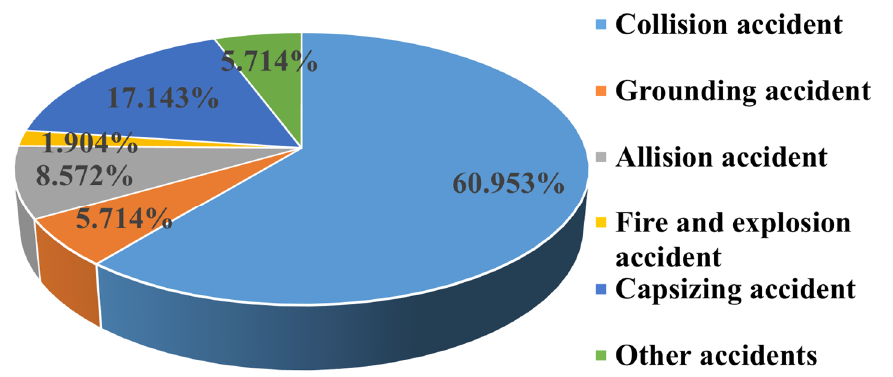
Figure 3. The proportions of different marine accidents.